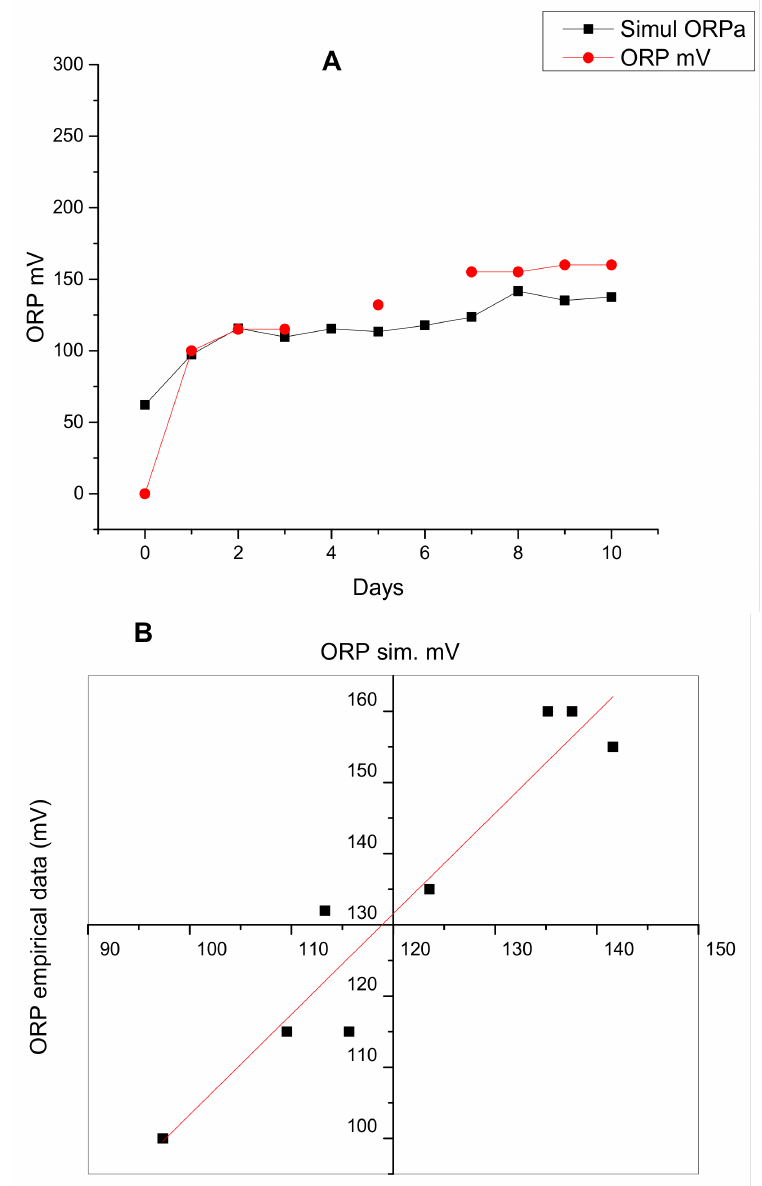
Figure 8. Simulated nitrification over ORP values. ( A ) values obtained by simulation and ( B ) Regression analysis between empirical and simulated